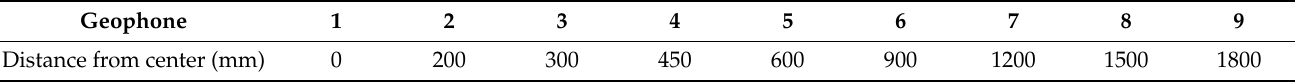
Table 1. Geophone array of the utilized FWD